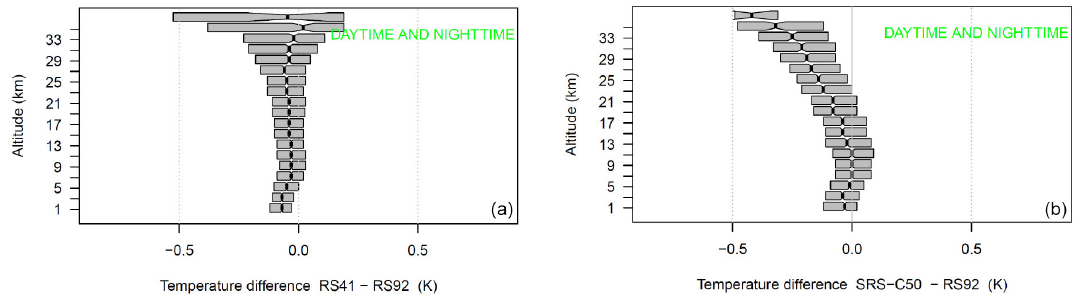
Figure 3. Overall temperature deviations at 11:00 and 23:00UTC of RS41 (a) and SRS-C50 (b) with respect to the reference sonde RS92. The interpretation of the graphics is the same as for the previous figures.